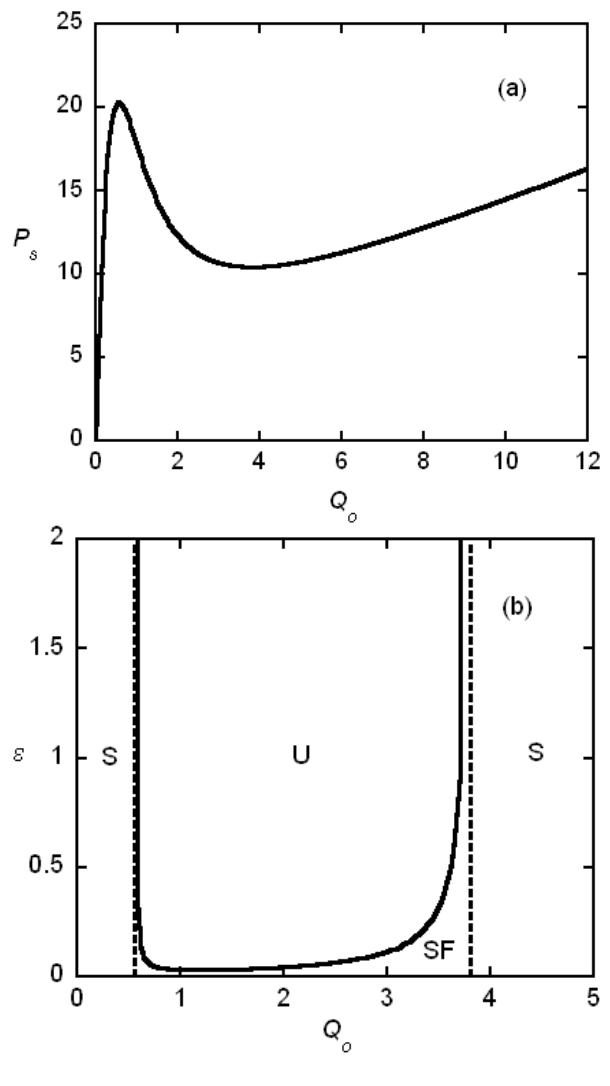
Fig. 3. (a) Steady state overpressure P s as a function of the flow rate Q o at the base of the conduit for the MBG model with β =5.5. (b) Steady state stability phase diagram in parameter space ( Q o , ε) for β =5.5 for the MBG model. S=stable node; SF=stable focus; U=unstable focus. The Hopf bifurcation line (continuous curve) resides within the region where the steady state P s (Q o ) exhibits two extrema (dashed vertical lines).